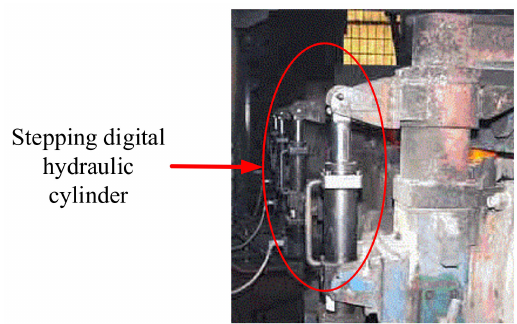
Figure 31. Practical application of digital hydraulic